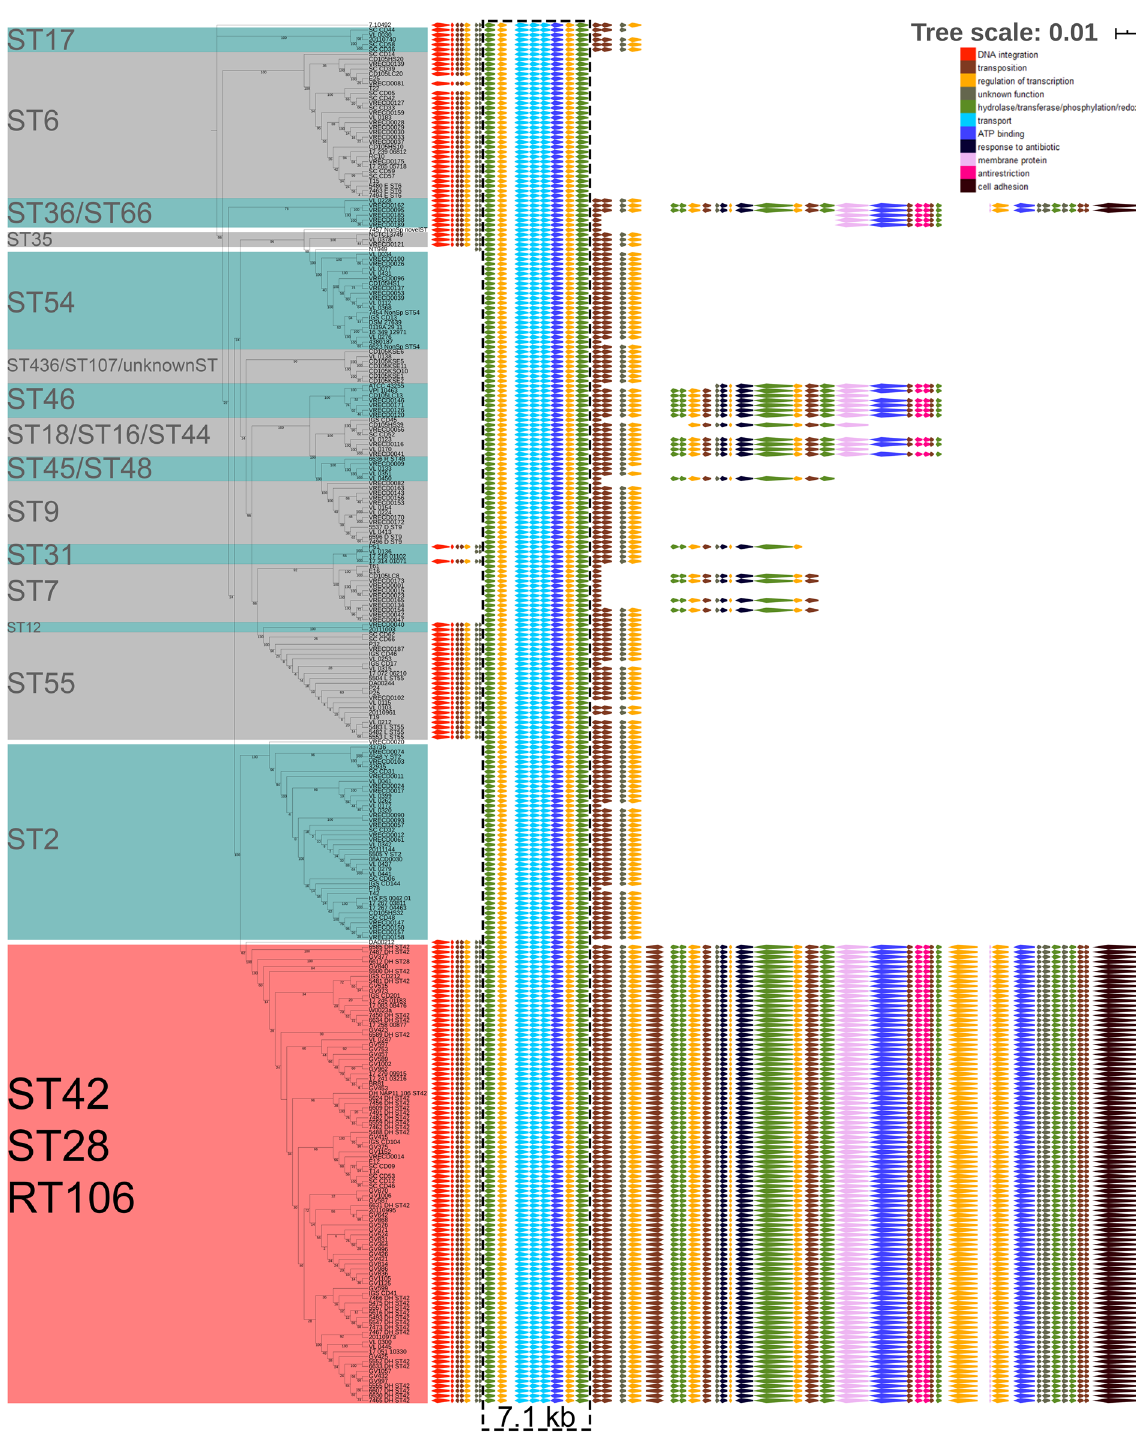
Figure 3. RT106 strains harbor a complete and unique 46 kb genomic island 1. The relatedness of the 265 C. difficile strains that carry GI1 segments (> 7.7 kb, 98% identity) is shown in a maximum likelihood tree (log likelihood = − 479,911.97) based on 40,879 core SNPs identified using Panseq. The percentage of replicate trees in which the associated taxa clustered together in the bootstrap test (1000 replicates) are shown next to the branches. GI1 is drawn to scale on the right to illustrate regions present in different sequence types (ST). Tree scale: 0.01 represents 0.01 substitutions per nucleotide site. The complete 46 kb GI1 is present in RT106/ST28/ ST42. Genes were colored based on functional categories from gene ontology (GO) analysis. A 7.1 kb region carried by all the strains (black dashed box) was used for determining progenitor STs of the element in the molecular clock analysis in Fig.